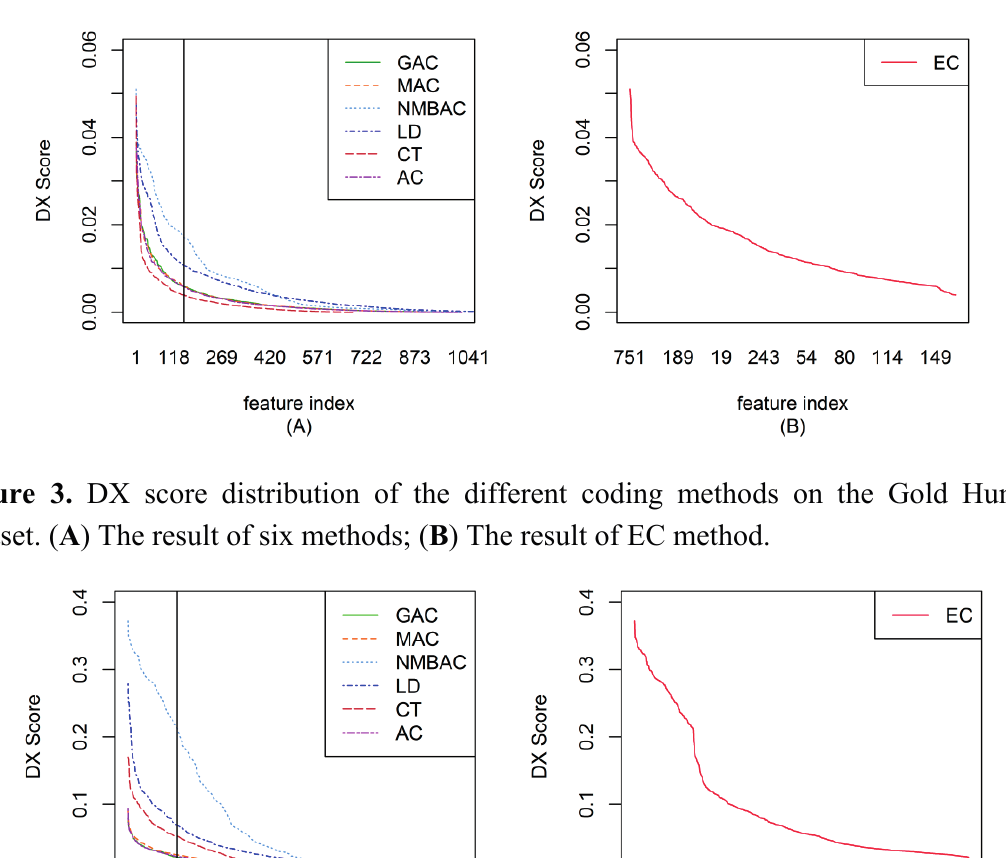
Figure 2. DX score distribution of the different coding methods on the Silver Yeast dataset. ( A ) The result of six methods; ( B ) The result of EC method.